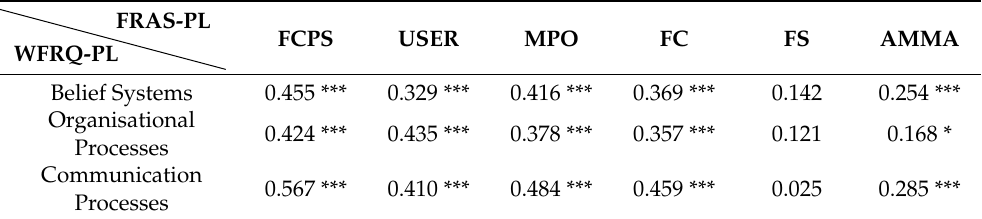
Table 5. Correlations between the 31-item Walsh Family Resilience Questionnaire-Poland Version (WFRQ-PL) factors and validation